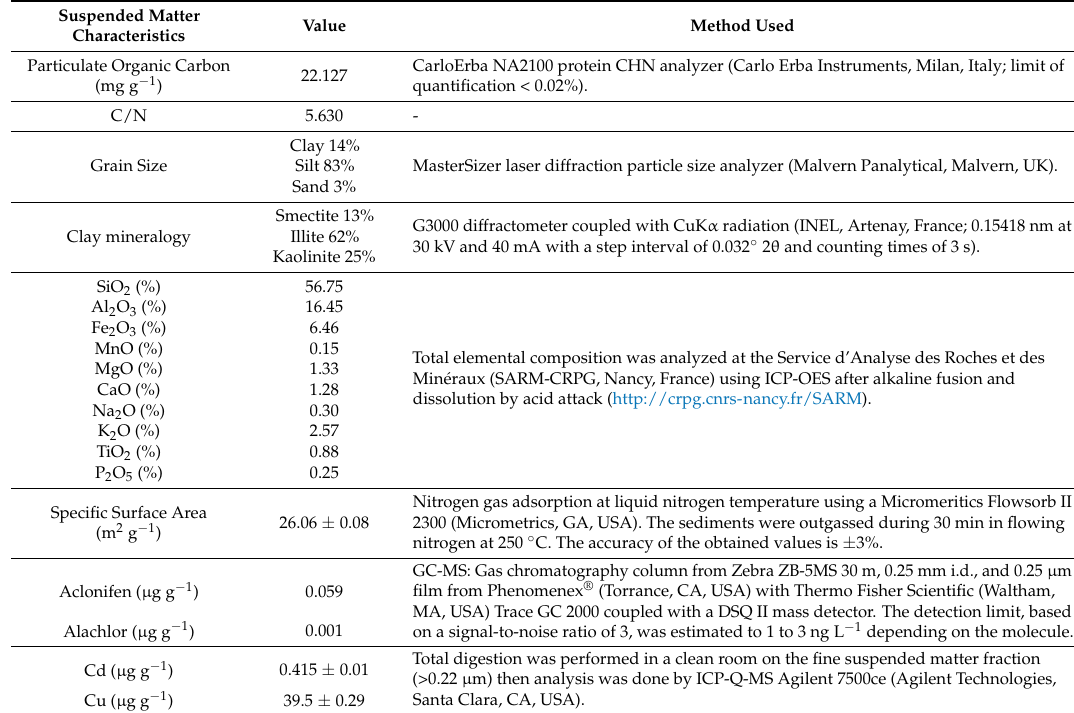
Table 3. Physico-chemical characteristics of the particles used in the adsorption experiments. Details of the methods used can be found in